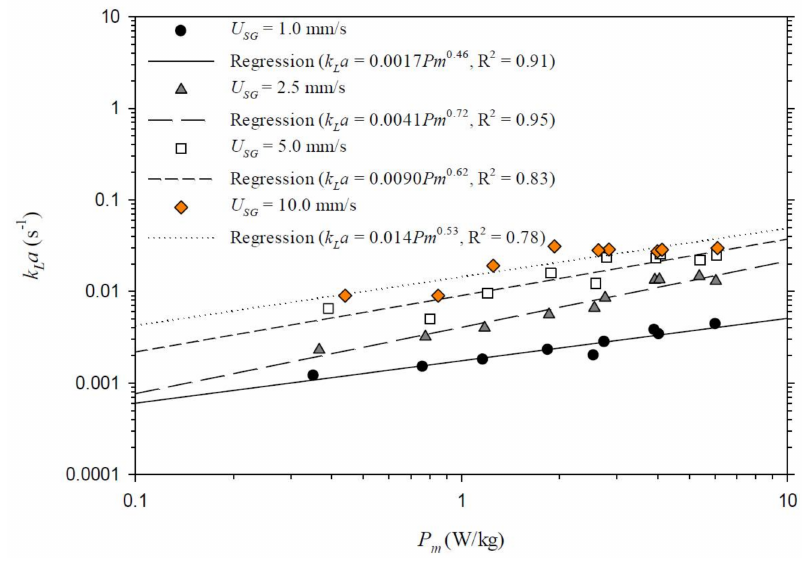
Figure 18. Regression results of Waghmare et al. [19] for U SG = 1.0 to 10.0